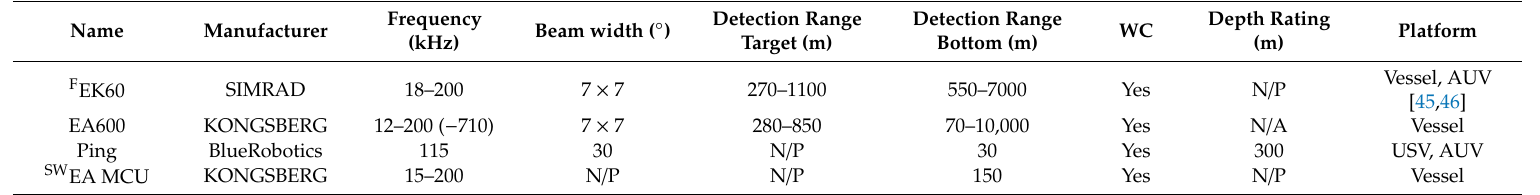
Table 5. Acoustic sensor: single-beam echo-sounder (SBES), F = fishery, SW = sweep, WC = water column.